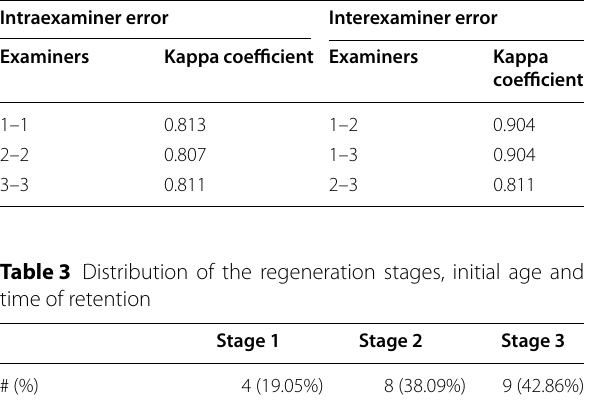
Table 2 Regeneration